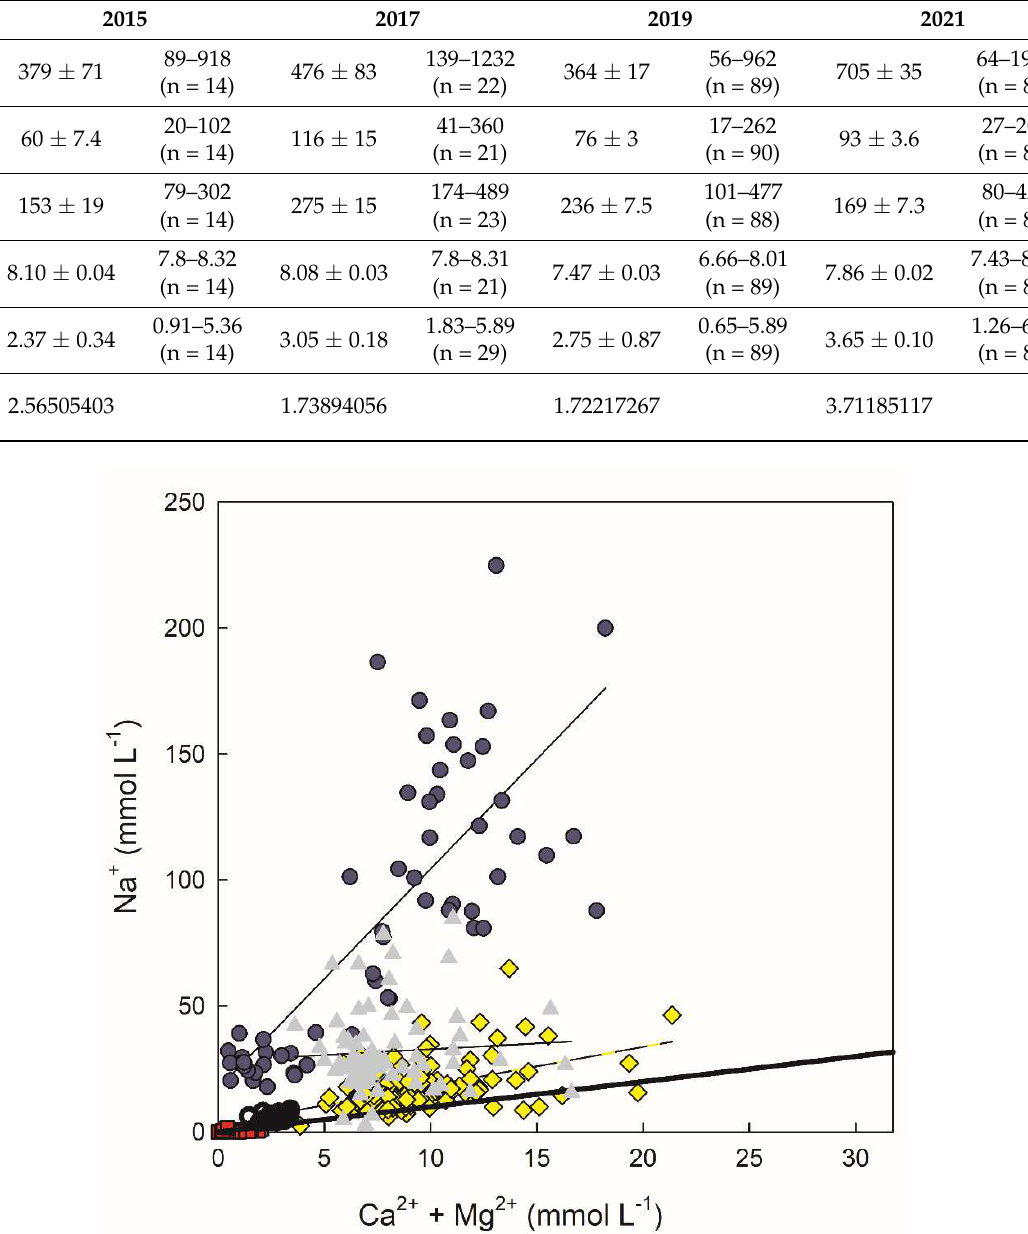
Figure 4. Relationship between Na + and divalent cations (Ca 2+ + Mg 2+ ) for natural sodic wetlands (blue circles, r 2 = 0.621), natural rich fens (red squares), and Sandhill Wetland in 2019 (yellow diamonds (r 2 = 0.233). Thick line is 1:1 concentration of cations in mmol L −1 . Sandhill Wetland samples taken from samples of surficial waters in vegetation plots and sippers. Table 3. Mean concentrations (±S.E.) and ranges of Na + , Ca 2+ Mg 2+ (mg L −1 ), pH, and electrical con- ductance (EC, mS cm −1 ) for Sandhill Wetland for 2015, 2017, 2019, and 2021. Ratios of Na + :Ca 2+ + Mg 2+ calculated as mmol L −1 .